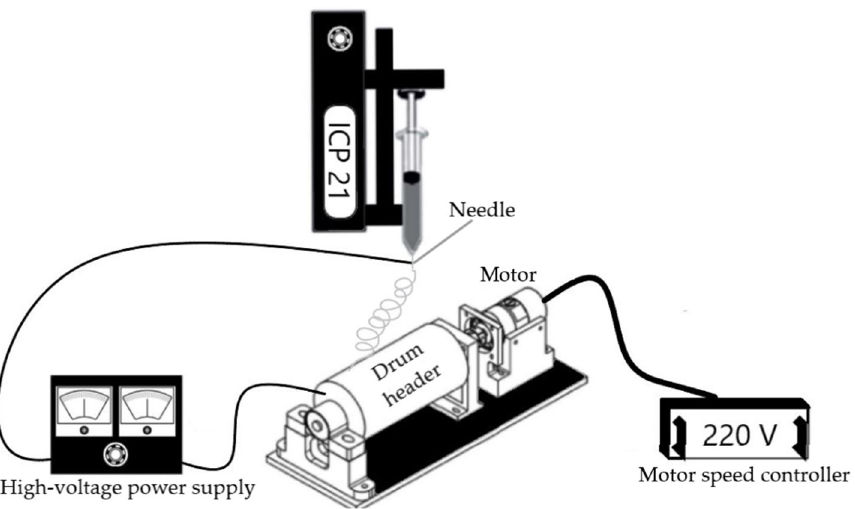
Figure 1. Scheme of the electrospinning